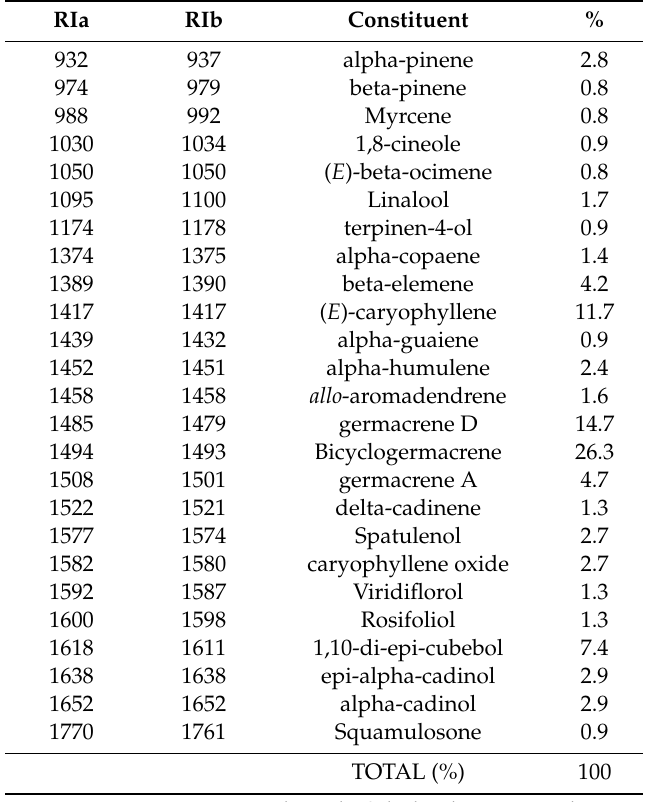
Table 1. Chemical constituents identified in the Croton ceanothifolius essential